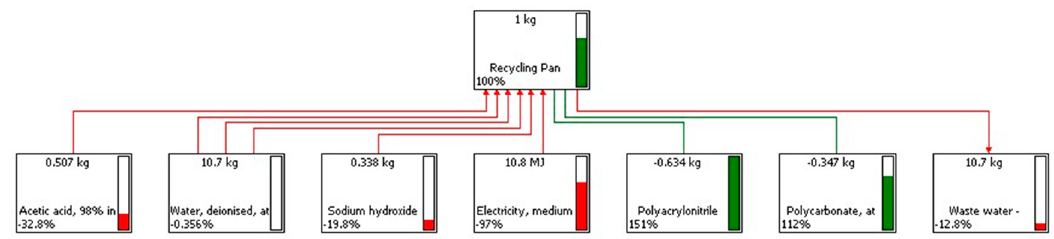
Figure 2. Network of the Connora recycling process according to the inventory data of Table 4. Percentage of GWPs is reported for each step according to the CML 2000 method.